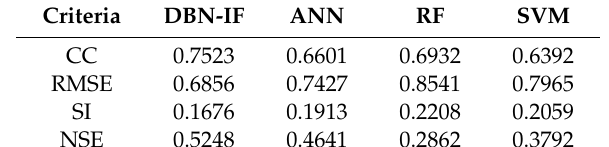
Table 12. The CC, RMSE, SI, NSE of WVHT predictions with lead time = 24 h.